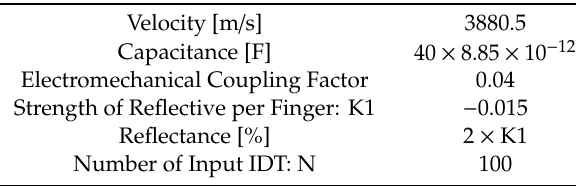
Table 1. COM parameters used in the modeling.